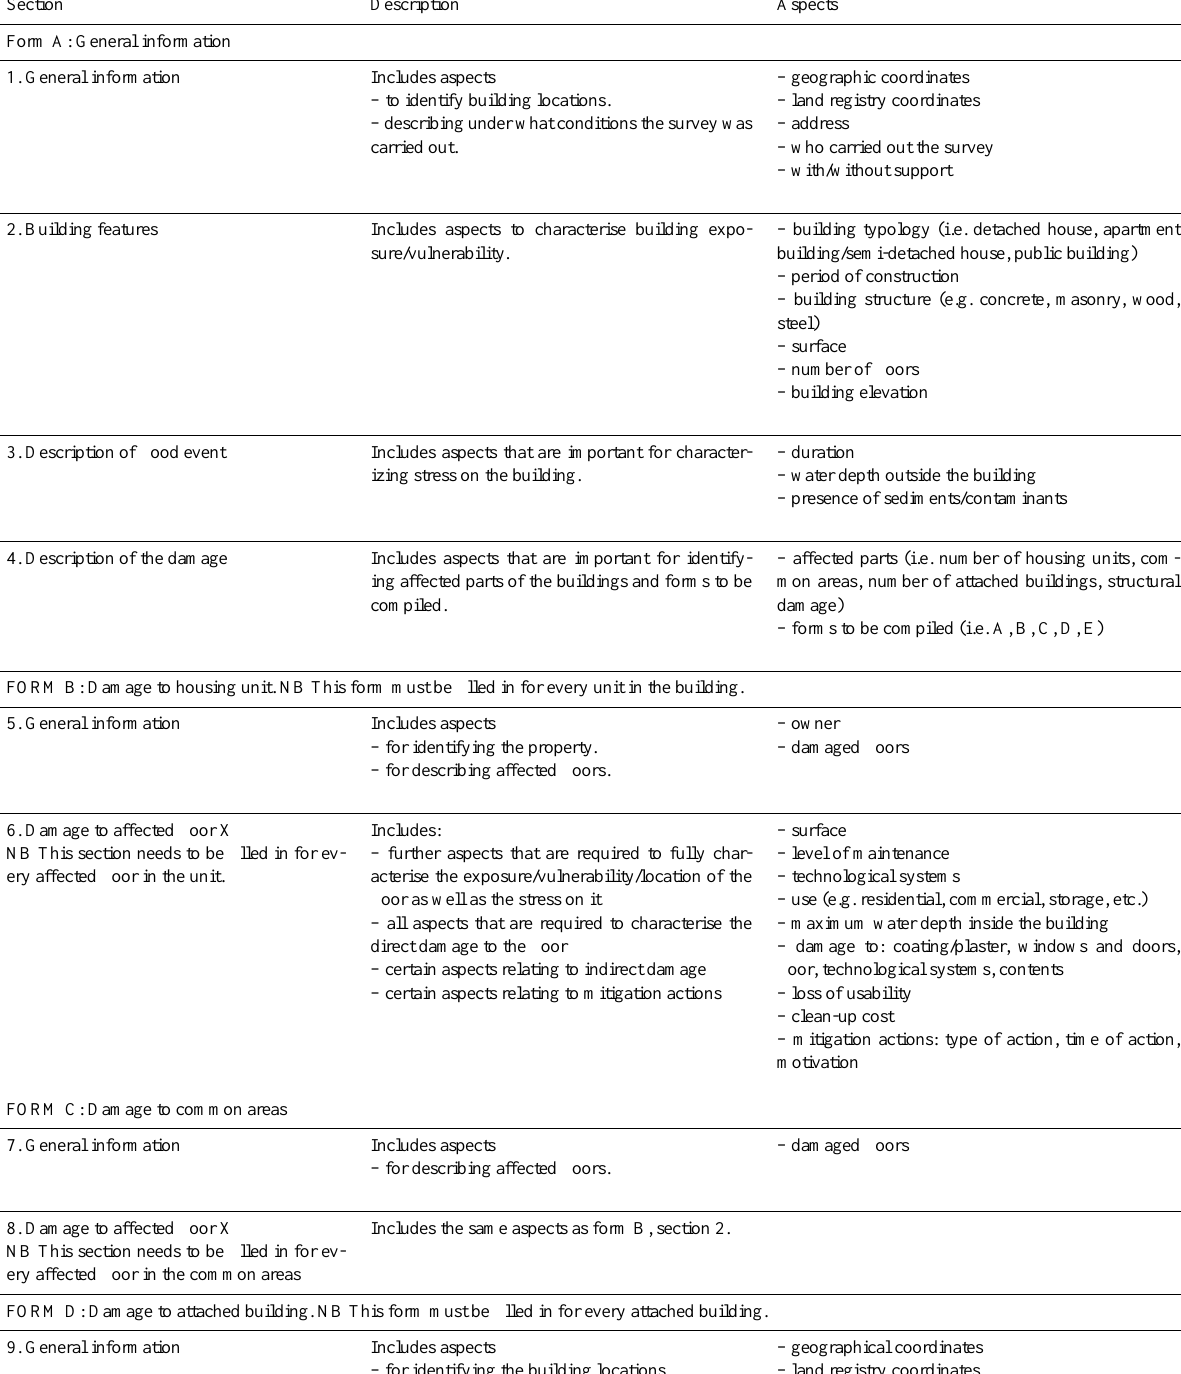
Table 2. Sections and relative aspects to be evaluated in the